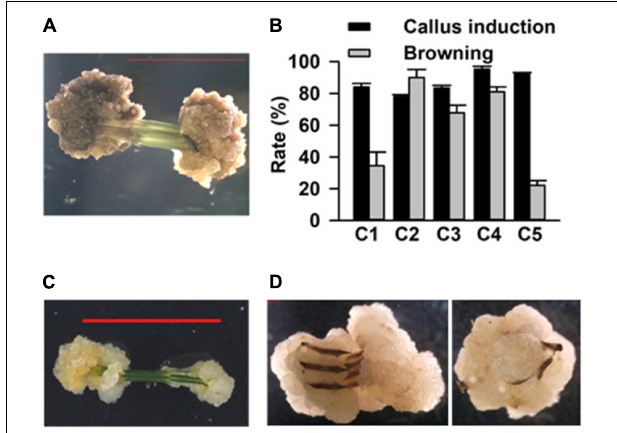
FIGURE 1 | Callus induction of Casuarina equisetifolia using the stem as explant. (A) Induced callus became brown. (B) Callus induction rate and browning callus rate in basal medium with different plant growth regulator (PGR) combinations. The results are presented as the mean and standard error from three independent experiments. (C) Inducement and (D) proliferation of calluses.